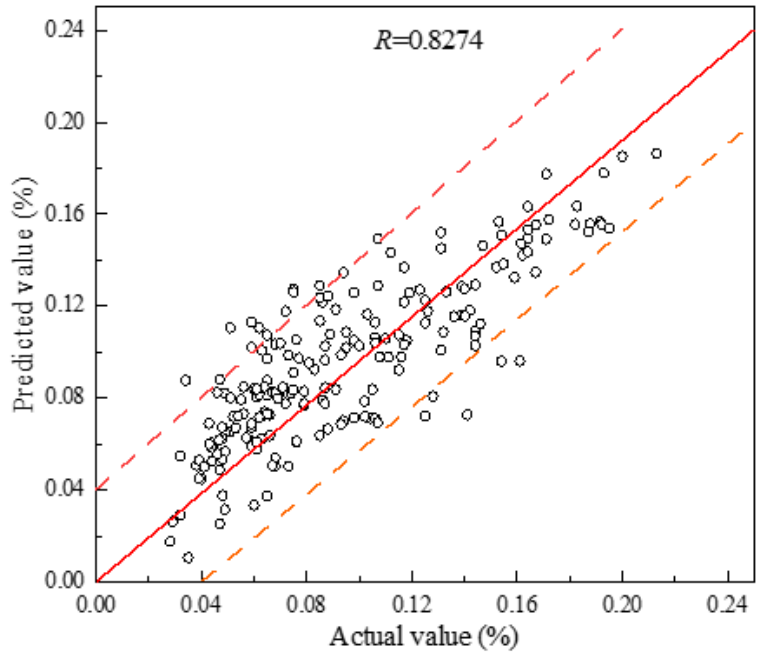
Figure 7. Comparison of predicted and actual values of end-point carbon content for improved ANN model. Figure 8 shows the frequency distribution of error of the improved ANN